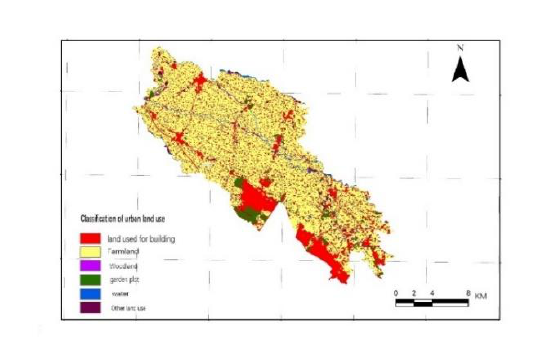
Figure 1 Classification of Land Types in 1998